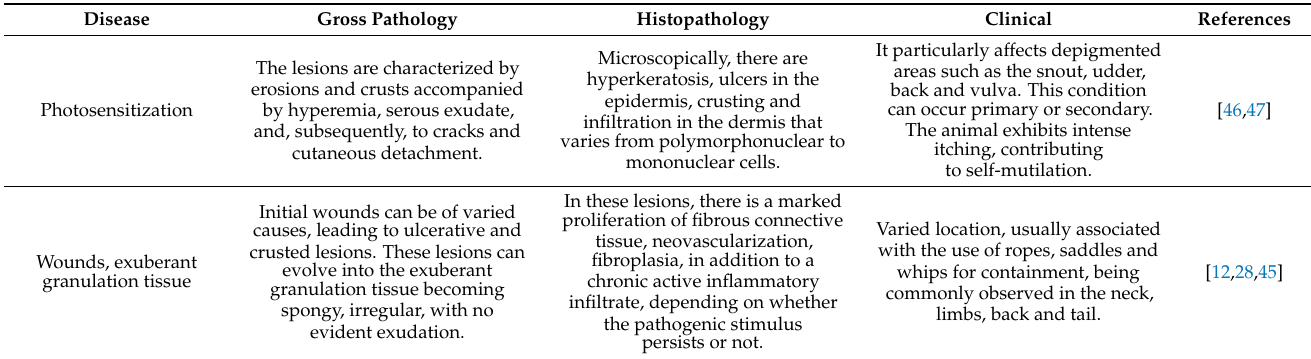
Table 4. Environmental disease described in donkeys and